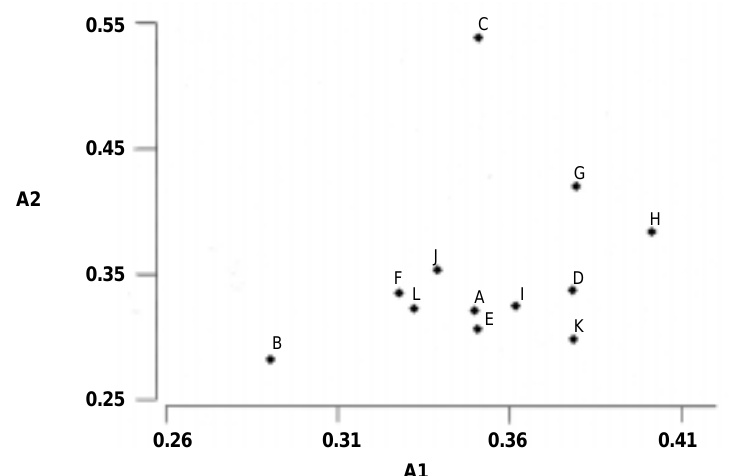
Figure 4 - Diagram projection of the mean intrachromosomal asymmetry index (A1) against the mean interchromosomal asymmetry index (A2) of 12 populations of Mikania micrantha. A = Alfredo Guedes, B = Campinas, C = Estrela do Norte, D = Petrópolis, E = Piracicaba, F = Praia Grande, G = Praia de Ipanema, H = Joinville, I = Apucarana, J = Foz do Iguaçu, K = Guaíba, L =